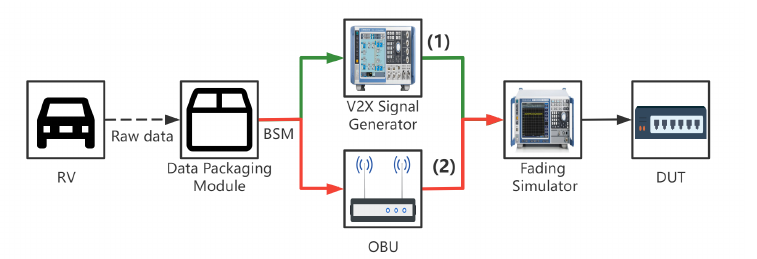
Figure 9. Hardware architecture diagram of V2X simulation test: (1) V2X signal generator, (2) OBU as signal